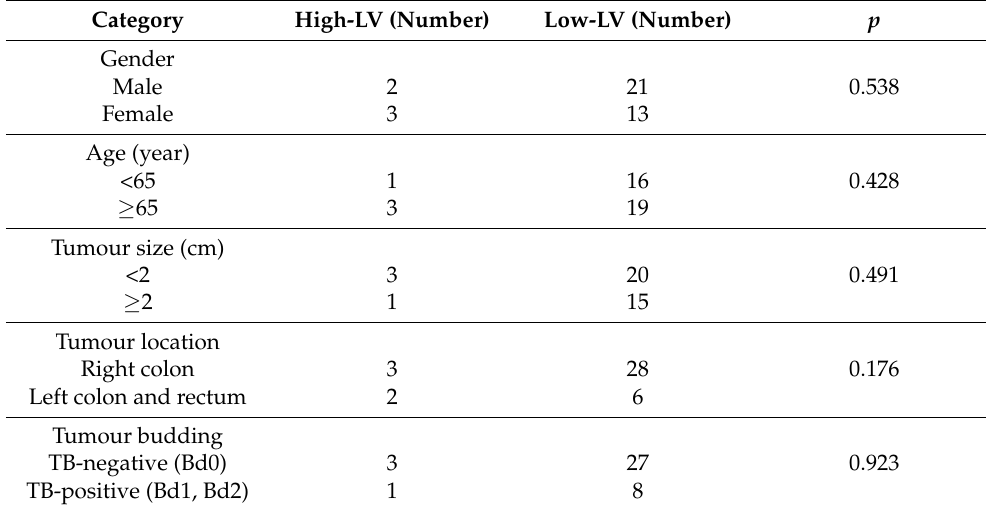
Table 2. Clinicopathologic characteristics of pTis colorectal carcinomas according to lymphatic vessel density.